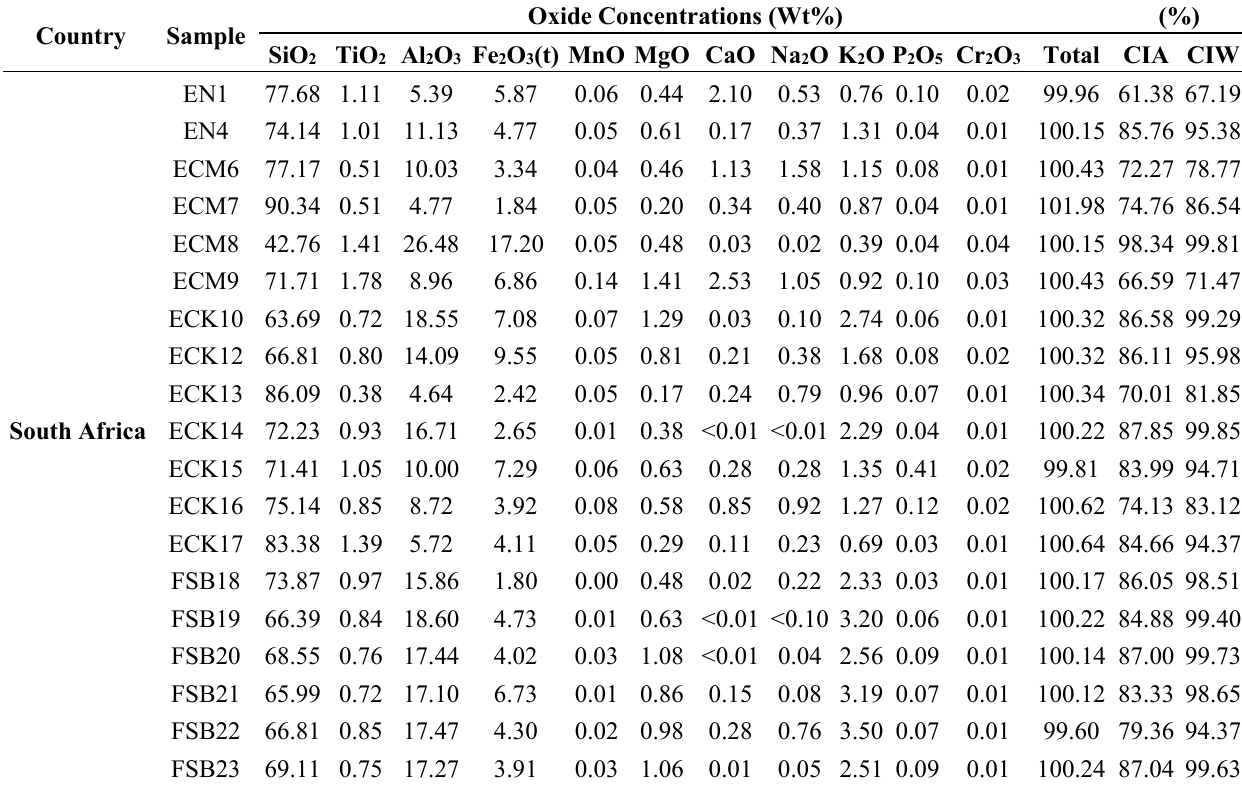
Table 2. Total concentrations of major and trace element oxides in geophagic